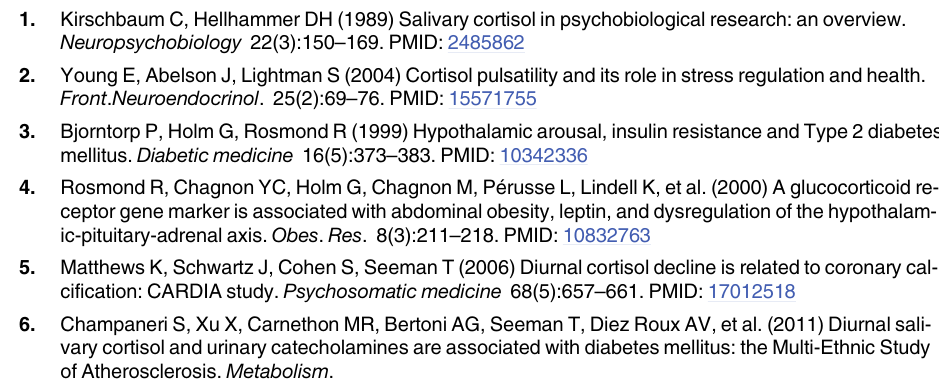
S1 Fig. LocusZoom plot of the association between all SNPs in the ADRB2 gene region and cortisol features in European Americans. Each SNP in the ADRB2 gene region was analyzed by MultiPhen (O ’ Reilly et al., 2012). The p-values were plotted using LocusZoom (Pruim et al., 2010). S2 Fig. LocusZoom plot of the association between all SNPs in the ADRB2 gene region and cortisol features in African Americans. Each SNP in the ADRB2 gene region was analyzed by MultiPhen (O ’ Reilly et al., 2012). The p-values were plotted using LocusZoom (Pruim et al., 2010). S3 Fig. LocusZoom plot of the association between all SNPs in the ADRB2 gene region and cortisol features in Hispanic Americans. Each SNP in the ADRB2 gene region was analyzed by MultiPhen (O ’ Reilly et al., 2012). The p-values were plotted using LocusZoom (Pruim et al.,